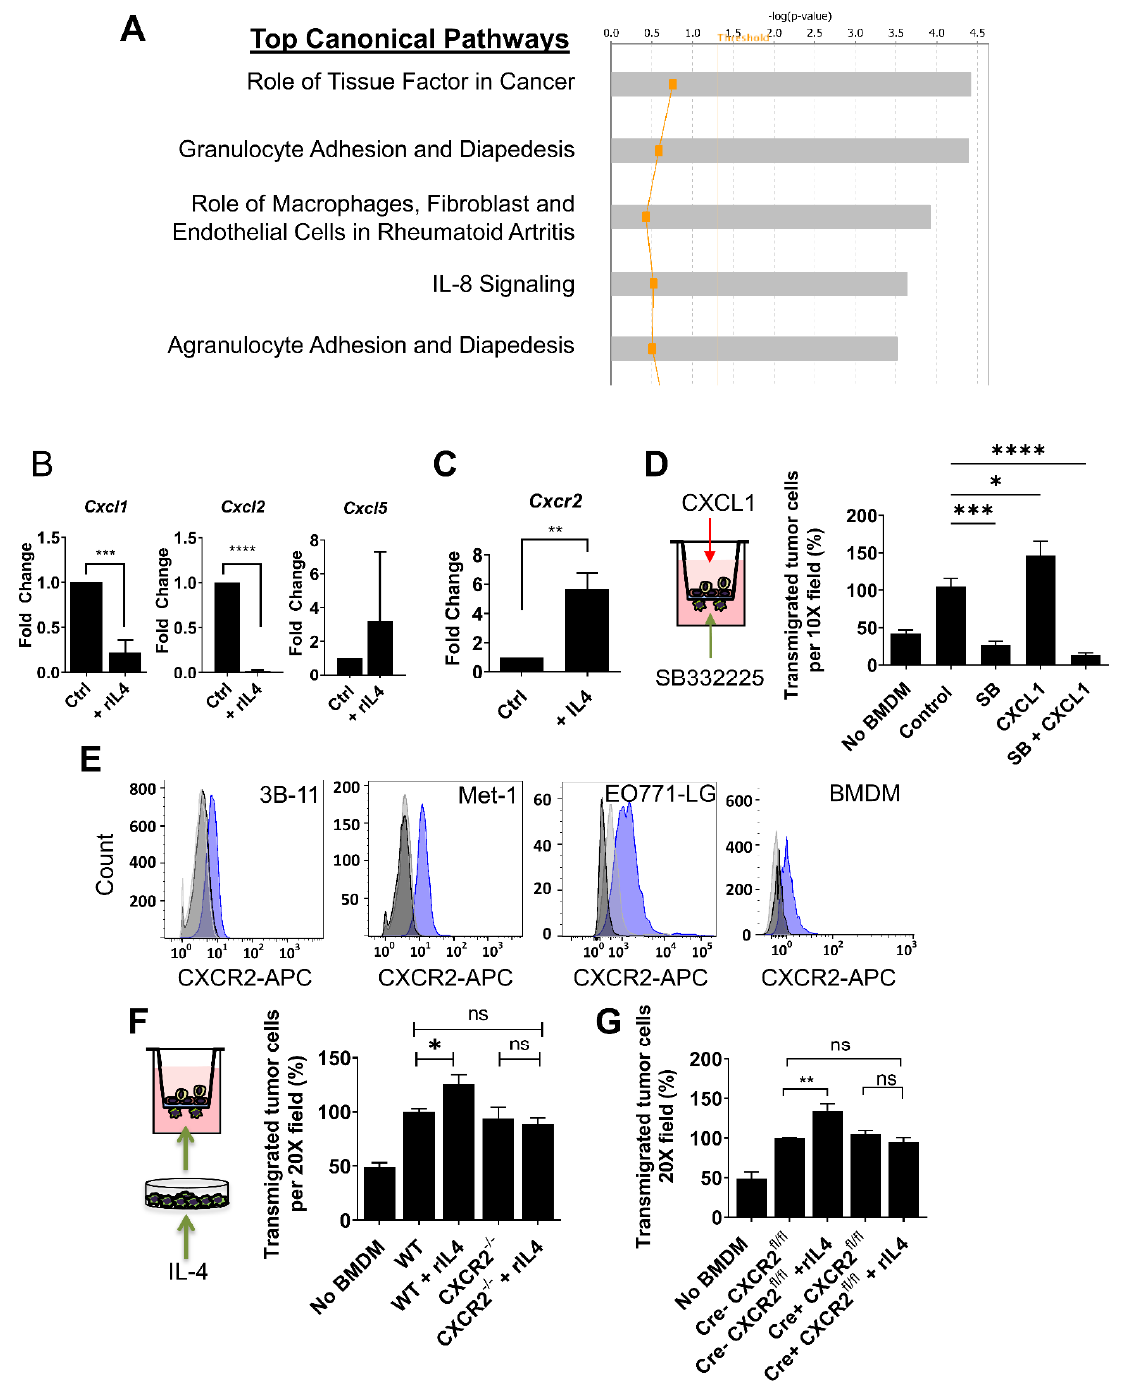
Figure 4. CXCR2 is controlled by IL4 signaling in macrophages, and it mediates the IL4-dependent transendothelial migration of tumor cells. ( A ) Top 5 canonical pathways derived from